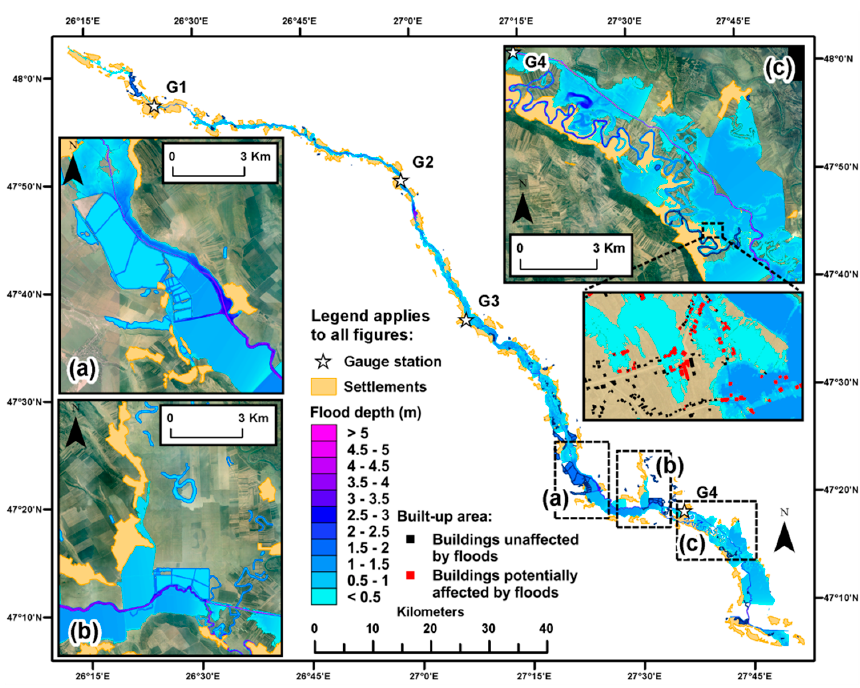
Figure 6. Flood depth derived from 1D HEC-RAS modeling based on LiDAR data (0.5 m spatial resolution) and Q max . (m 3 /s) flow rates with 1% (100-year) recurrence intervals estimated for each gauging station (G1, G2, G3, and G4). The 1% (100-year) flood depth pattern is highlighted in the sections ( a – c ).